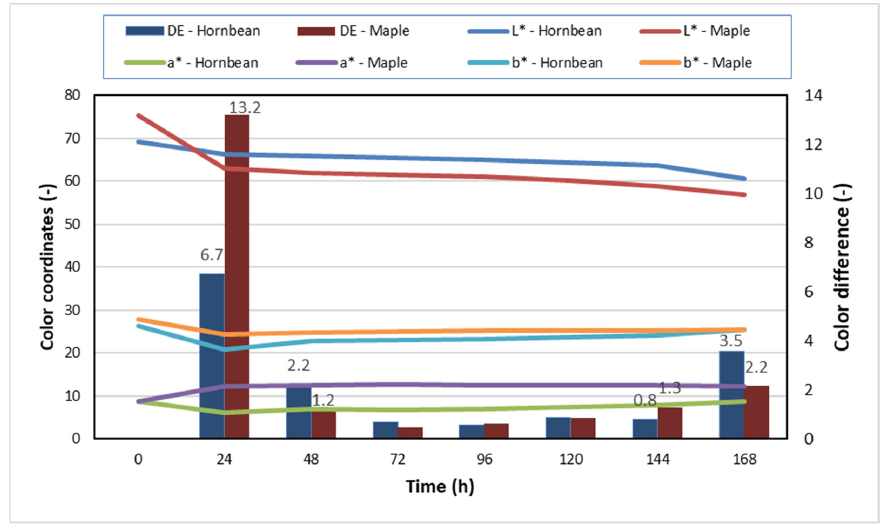
Figure 4. Change of color space coordinates and size of color difference during high-temperature drying (120 °C).